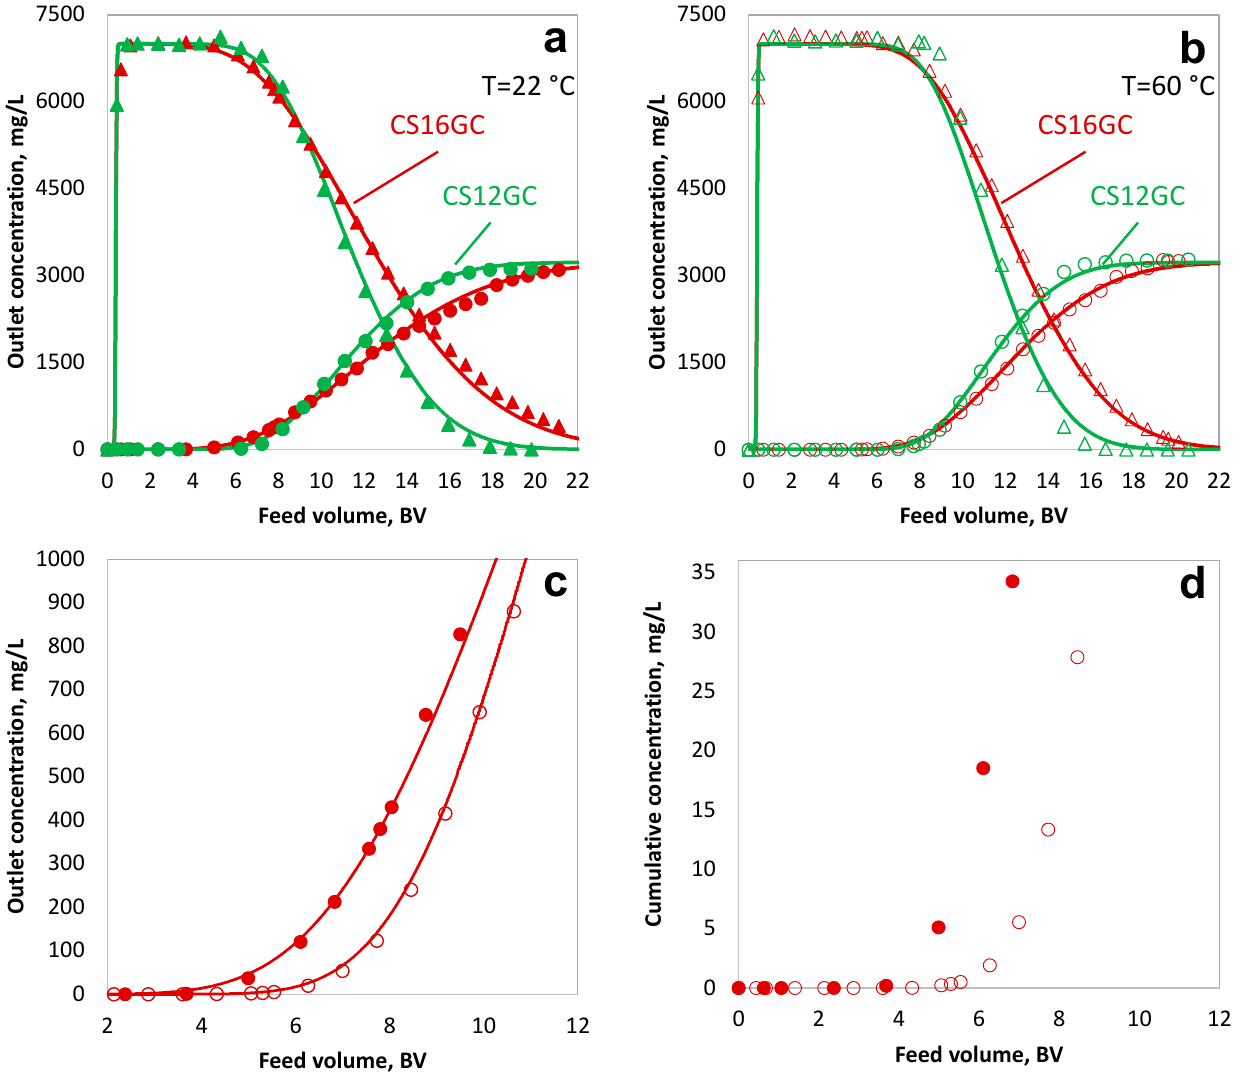
Figure 1. Ammonium and potassium profiles at the column outlets for the removal of ammonium from condensate with CS12GC and CS16GC cation-exchange resins in K + form of ( a ) temperature at 22 ◦ C, ( b ) temperature at 60 ◦ C; ( c ) ammonium concentrations at the column (CS16GC) outlet; ( d ) cumulative ammonium concentrations (CS16GC column). Experimental (symbols) and simulated (lines) data for the loading step ( V bed = 35.34 mL, Q = 3 BV/h, feed 0.179 mol/L NH 4 Ac). Open symbols: T = 60 ◦ C, filled symbols: T = 22 ◦ C. Red symbols and lines: CS16GC resin; green symbols and lines: CS12GC resin. Triangles: K + ; circles: NH 4+ .